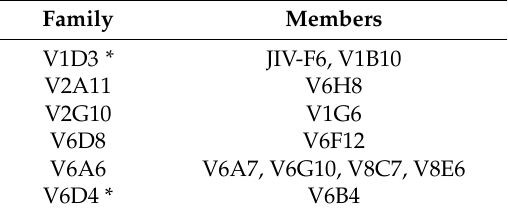
Table 1. V H H Families based on CDR3 similarity.